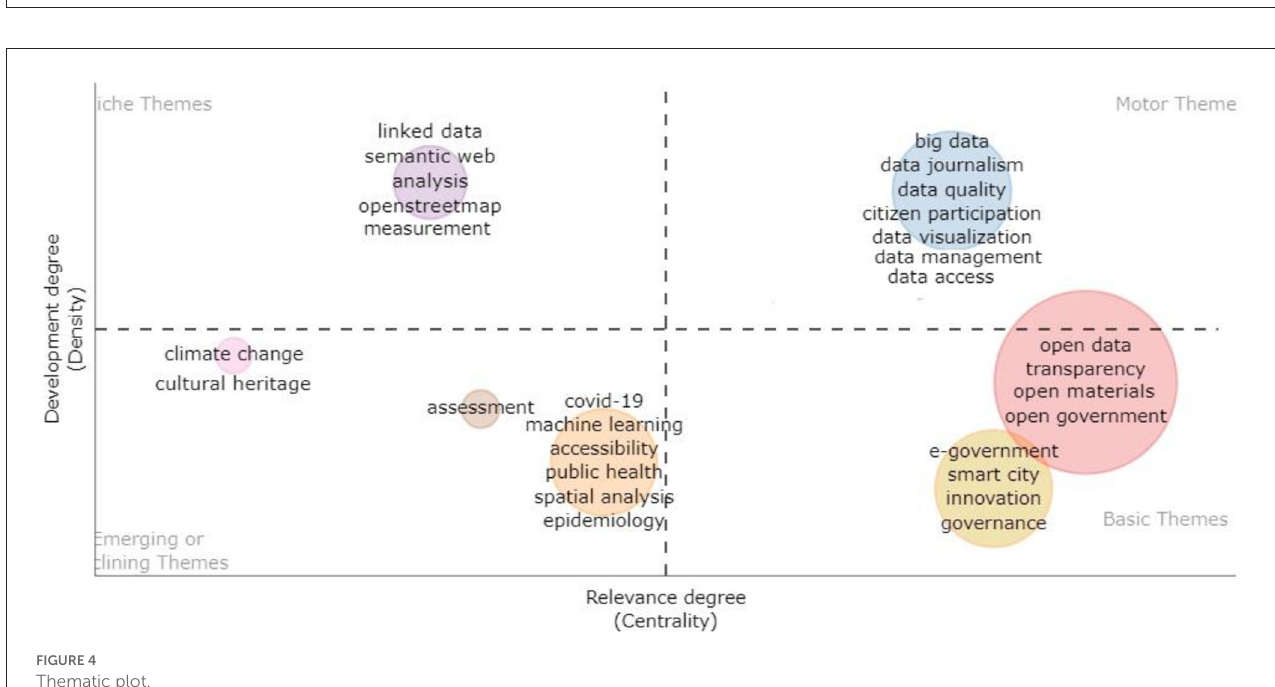
FIGURE3 Multiple correspondence analysis.